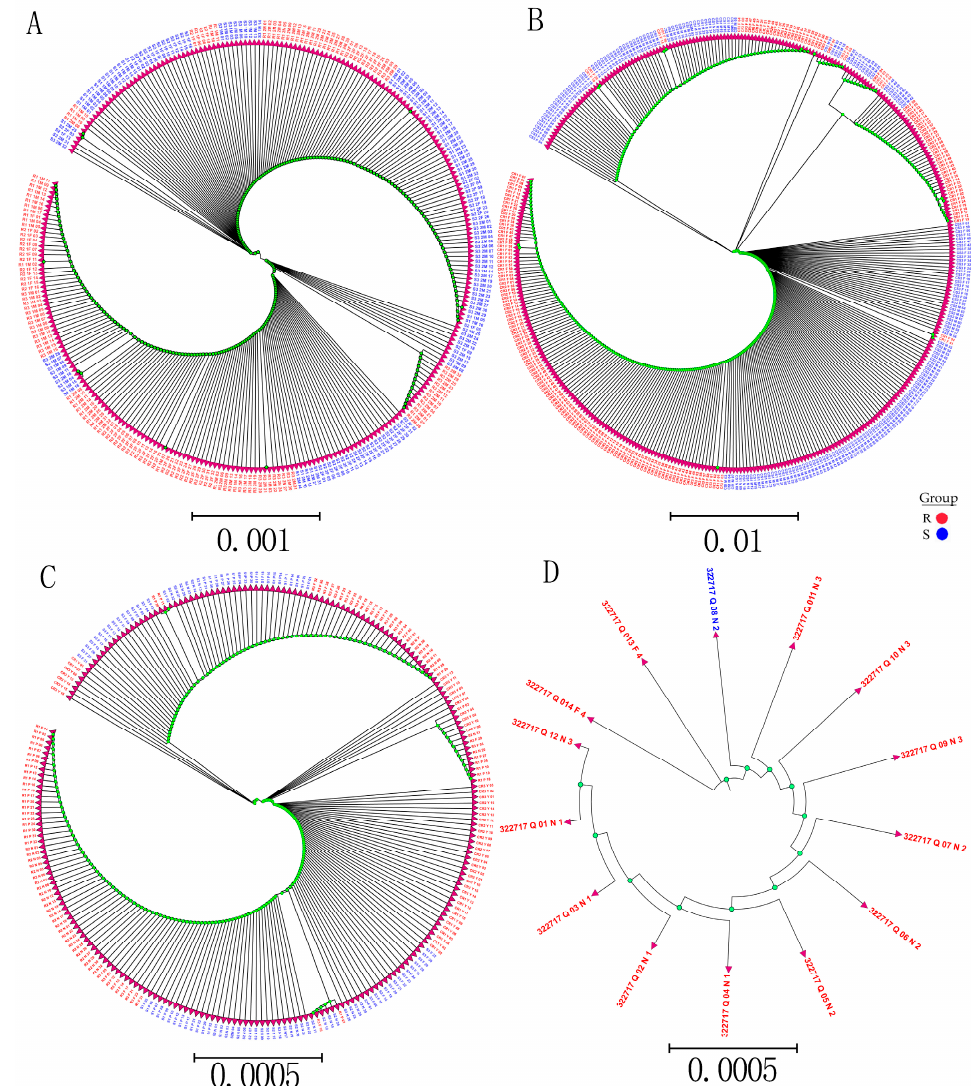
Figure A1. Phylogenetic trees of short DNA Sanger Sequencing of SNP KZ288474_322717 from 926 samples in different categories. ( A ) Phylogenetic trees of first and second SNP validation of R (resistant) and S (susceptible) of 288 samples from three Apis ceranacerana colonies in Minhou (M) (1 and 2 M) and F (Fuzhou) (1 and 2 F); ( B ) comparison of SNP validation of 384 samples from six colonies (three colonies resistant (CR) in Fuzhou and three colonies susceptible (CS) in Minho); ( C ) further SNP validation of 240 samples from six colonies and different geographic locations in P (Putian) (one colony), N (Nanping) (one colony), Fuzhou (one colony), and in Y (Yunnan Province) (three colonies); ( D ) SNP validation at the queen level of 14 colonies (12 colonies in Nanping and 2 colonies in Fuzhou). Neighbor-joining trees were constructed using MEGA 11 software with 1000-fold bootstrap resampling. The numbers at the bottom of each tree represent the level of evolution relationship difference between R and S samples after the trimmed